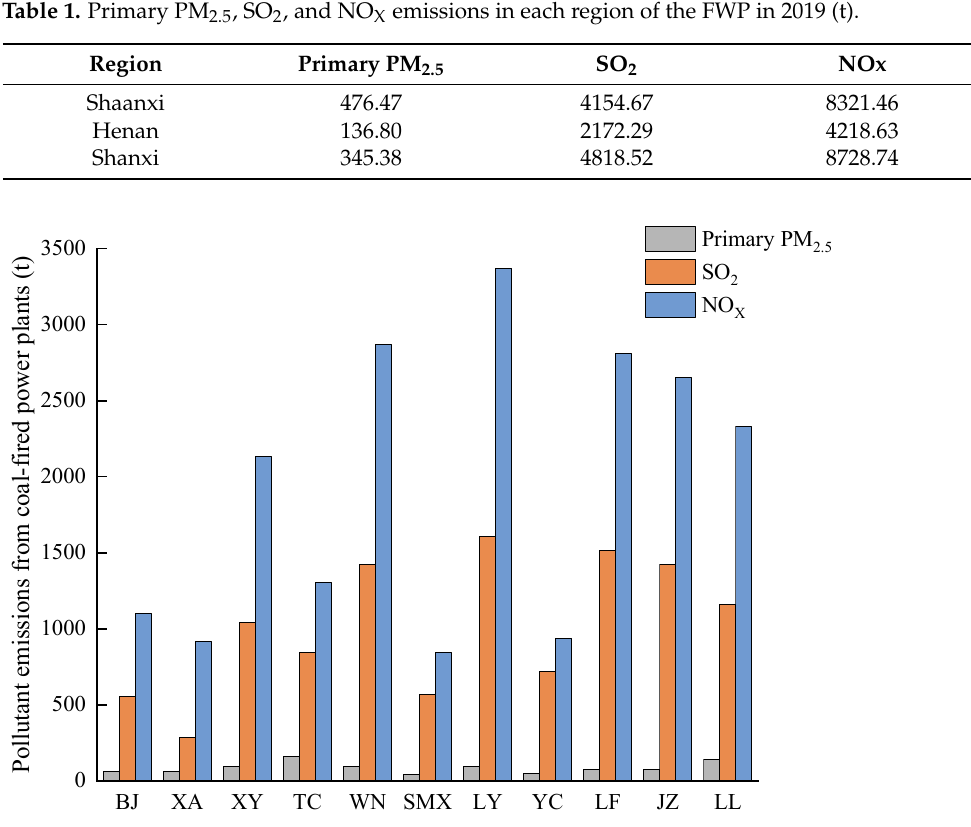
Figure 2. Pollutant emissions from coal-fired power plants with large units ( ≥ 300 MW) in 11 cities in the FWP in 2019.